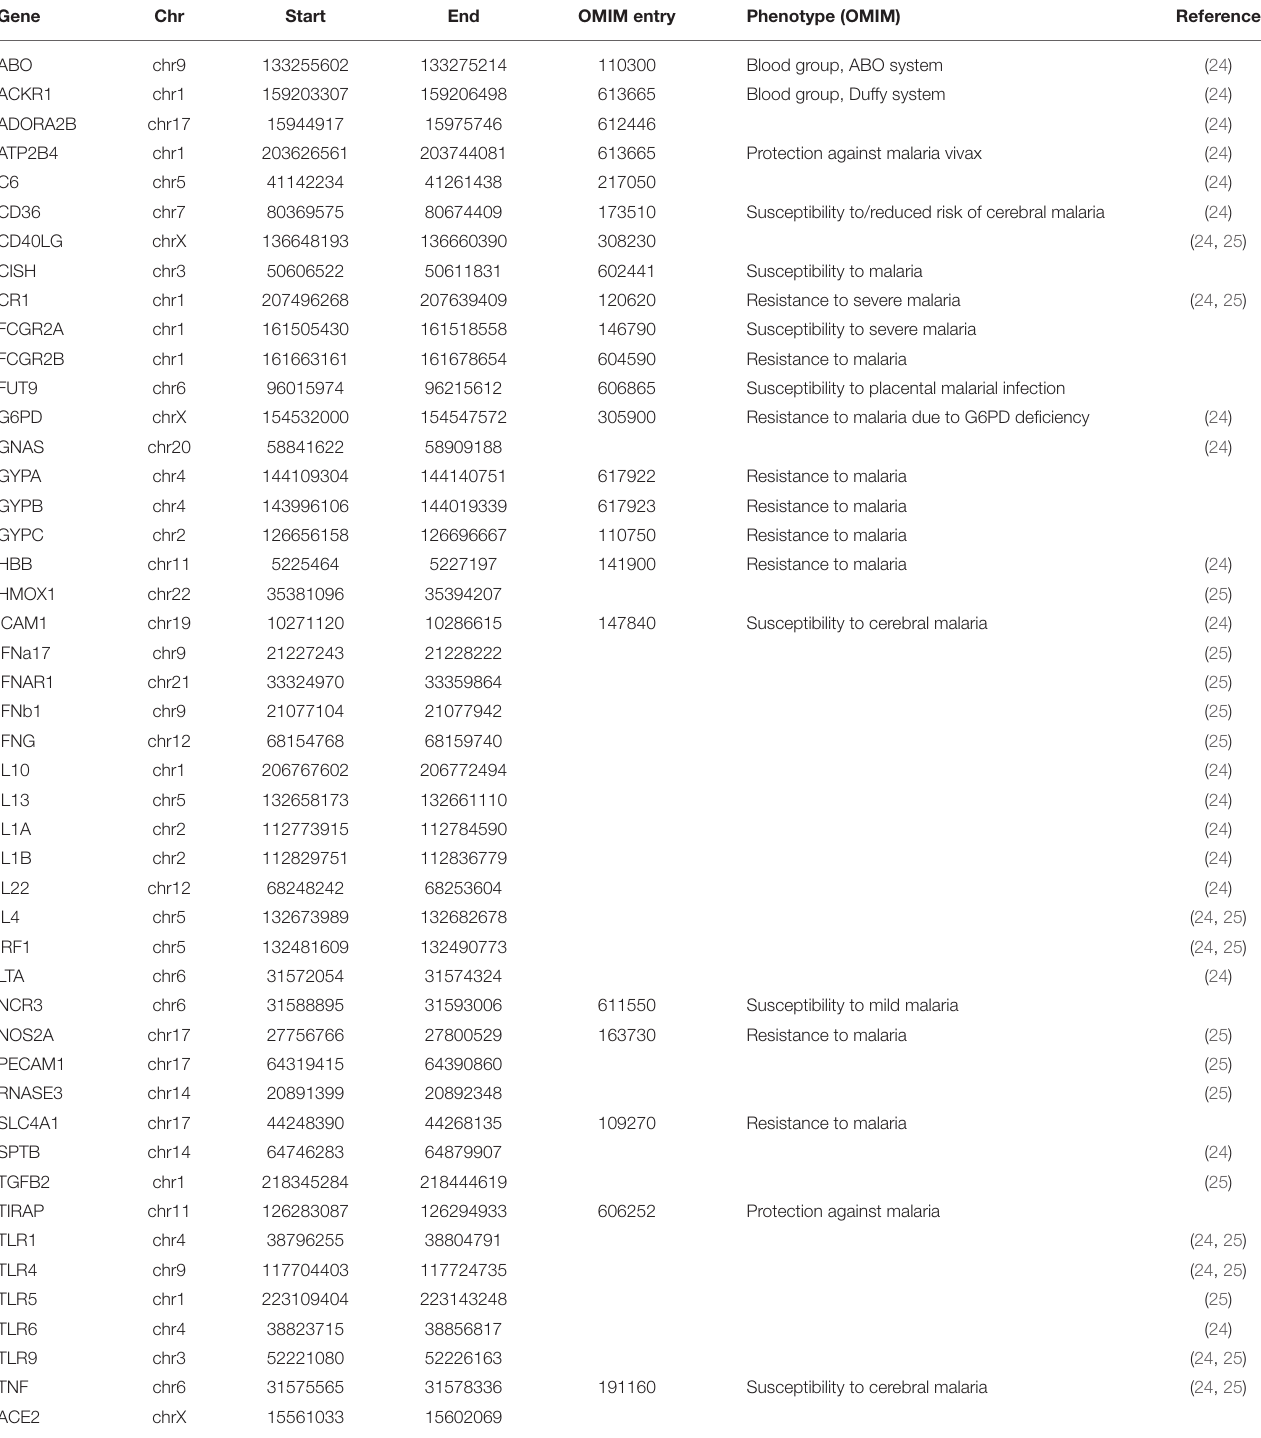
TABLE 2 | List of the genes included in the